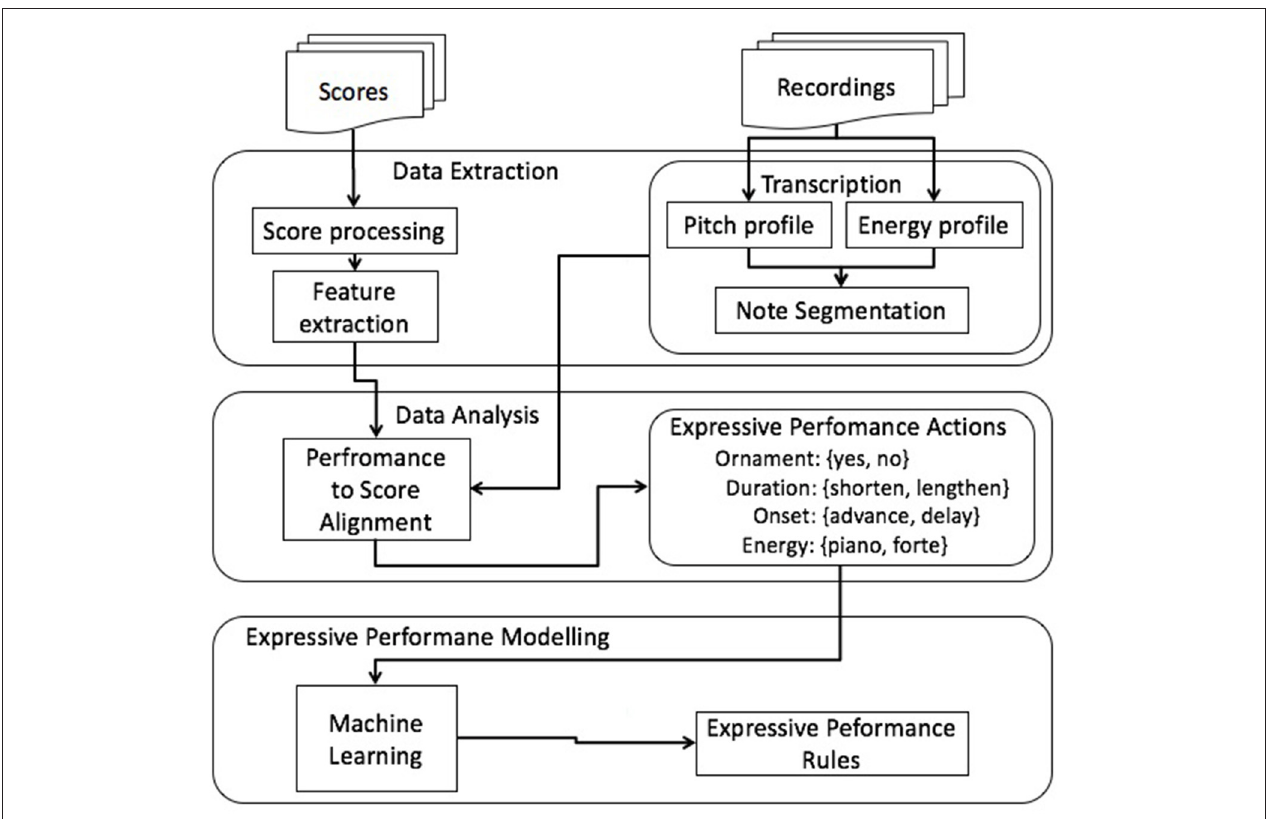
FIGURE 1 | General framework for EPAs modeling.